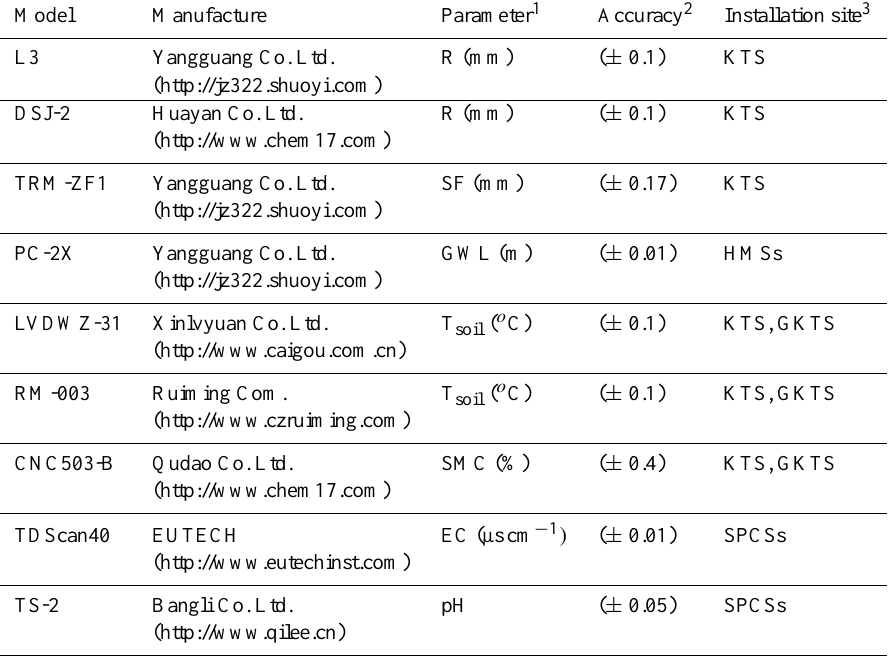
Table 3. Characteristics of the automated